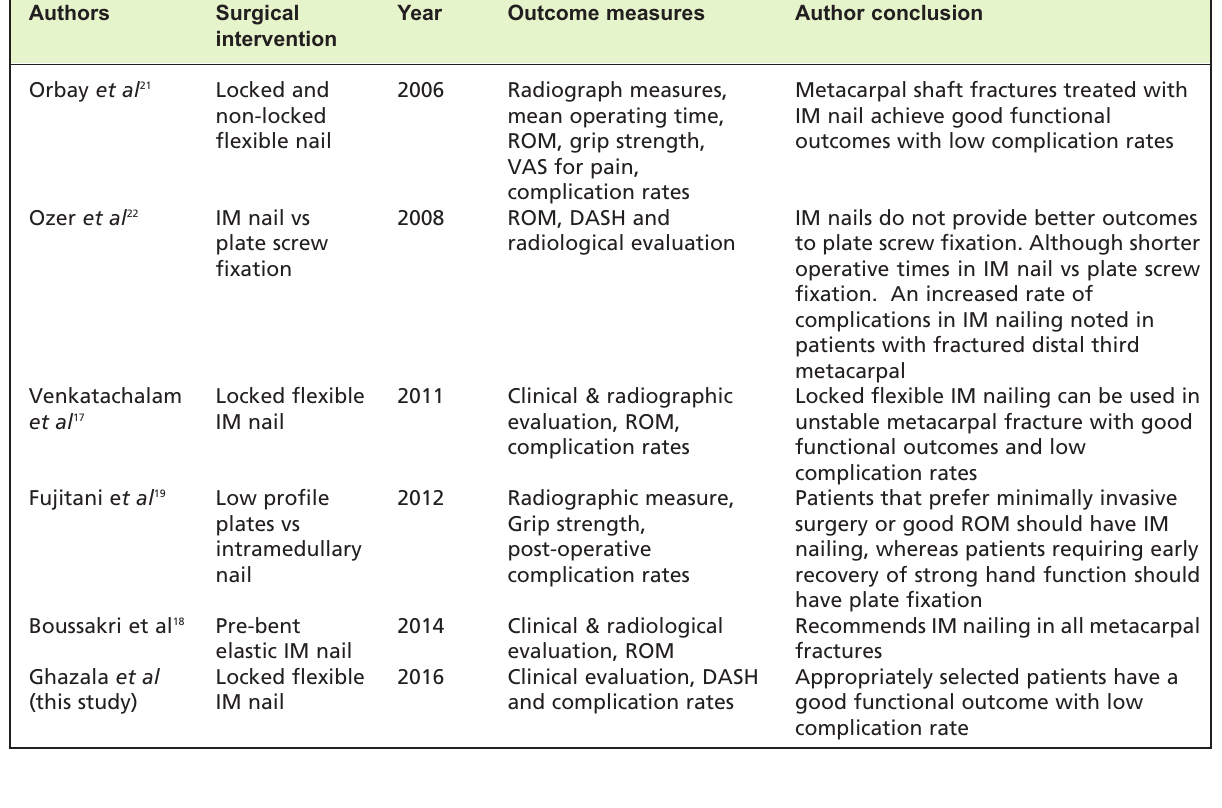
Comparative studies of metacarpal fracture Table IV: